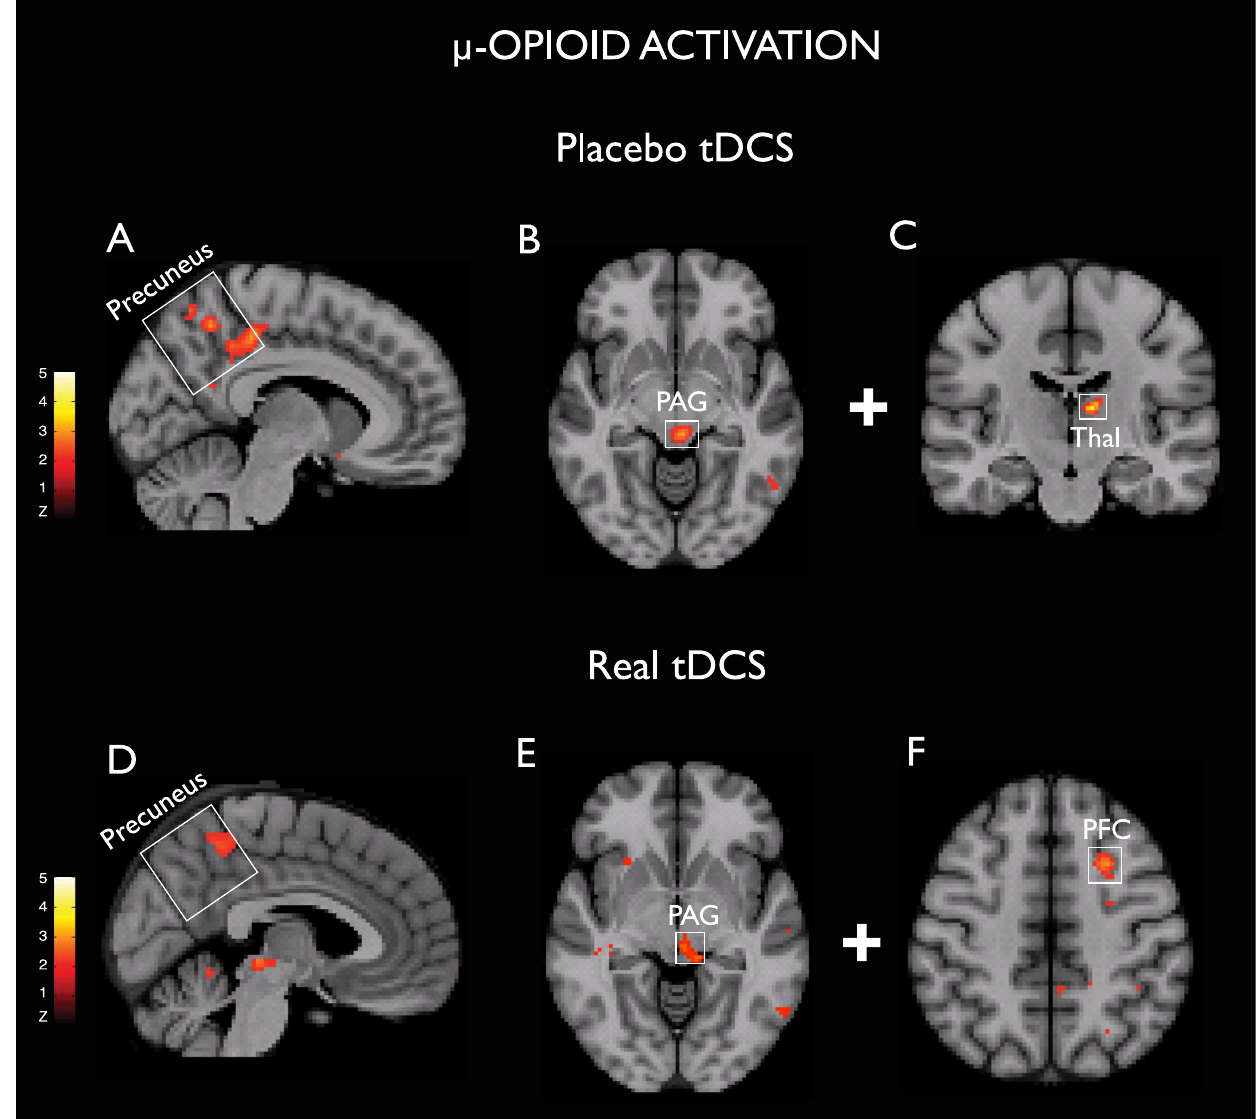
Figure 2. Changes in the m -opioid receptor availability induced by placebo (A–C) and real (D–E) tDCS. A and D, Representation of precuneus MOR activation in the sagittal plane. B and E, PAG MOR activation in the axial plane. C, Left thalamus (Thal) MOR activation in the coronal plane. F, Left prefrontal cortex (PFC) MOR activation in the axial plane. All images are radiological in orientation, threshold T 3–8.